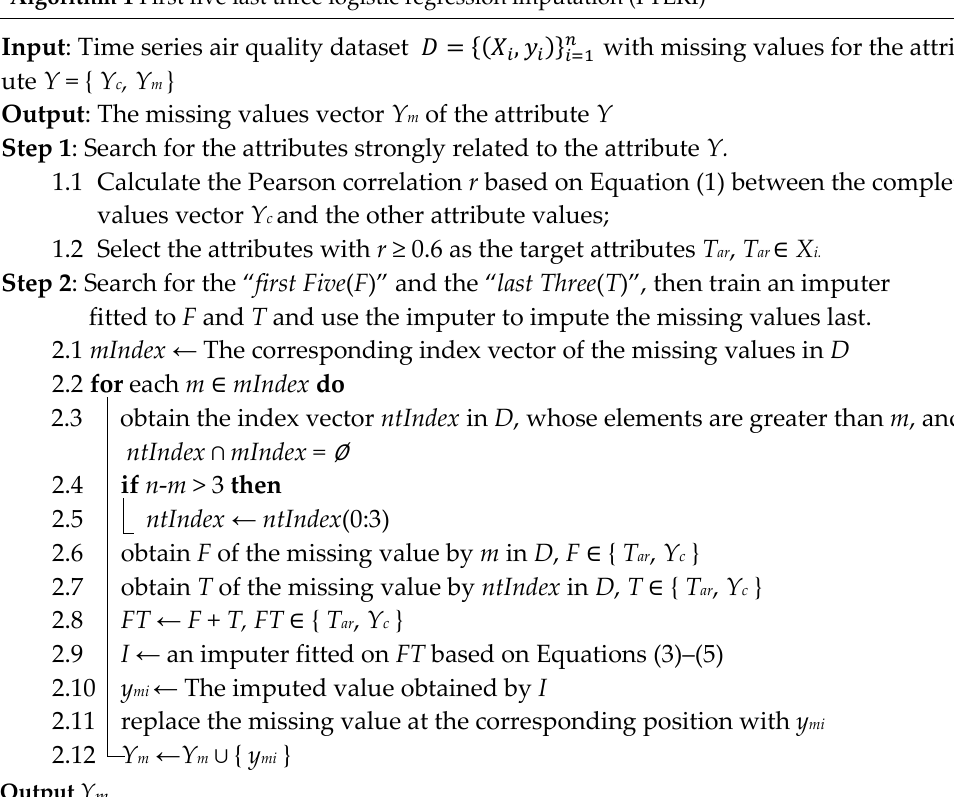
Figure 2. The illustration of FTLRI’s ideas. Algorithm 1 First five last three logistic regression imputation (FTLRI)